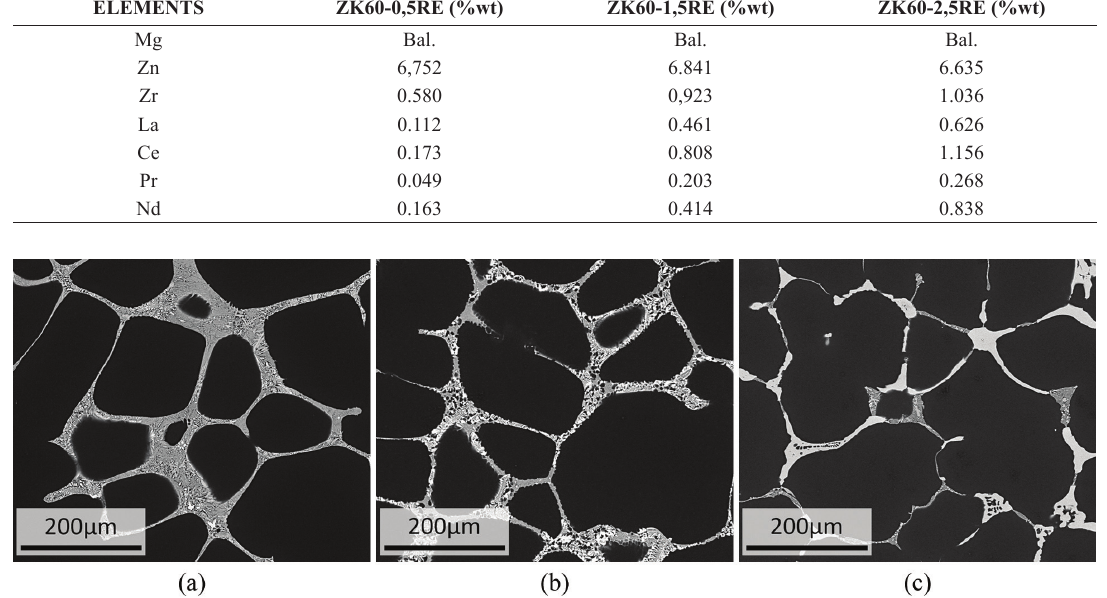
Figure 1. BSE images of the investigated ZK60 as-cast alloys: (a) 0.5 wt.%RE, (b) 1.5 wt.%RE, (c) 2.5